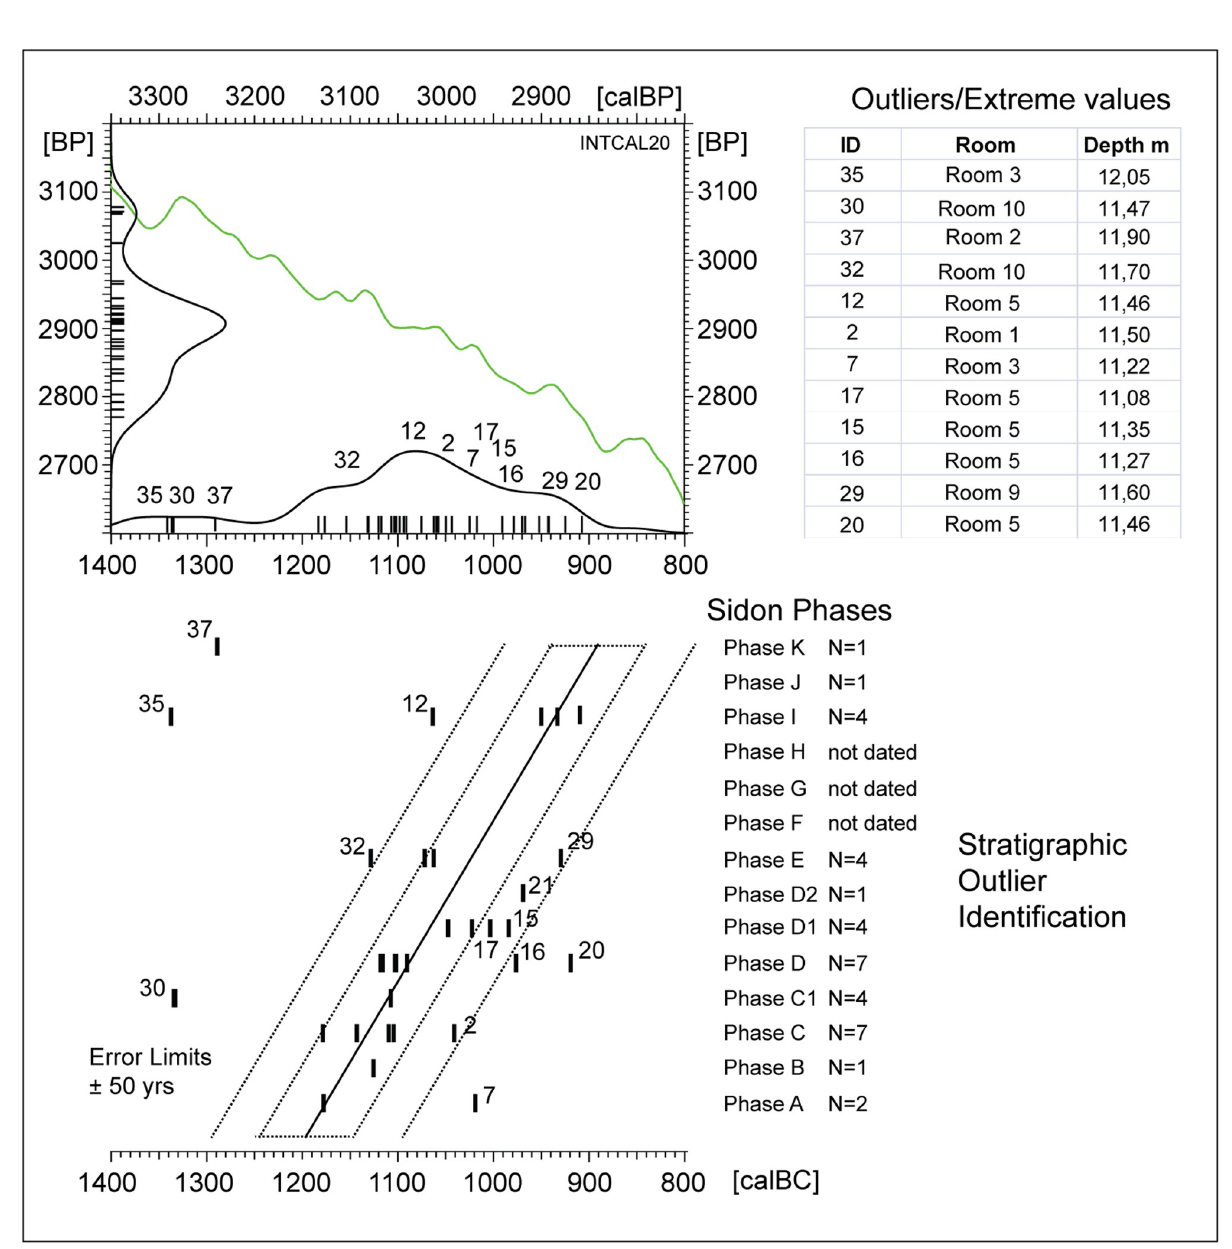
Fig 12. Identification of outliers and extreme 14 C-ages based on barcode representation of Sidon data (Table 1). In this graph all Sidon Phases (A-K) are included, with allowance for not-dated Phases F, G, and H. ( Upper) : 14 C-histogram and calibrated probability distribution of data, numbered according to Table 1, shown in context with IntCal20 (green line). ( Lower) : the same data, but showing barcodes grouped according to Sidon Phase (A-K), with Phases arranged vertically according to their known stratigraphic sequence. Note, empty vertical spaces are assigned to not-dated Phases F, G, and H. This procedure, in combination with the visual setting of oblique error-lines (dashed lines drawn at ± 50yrs (~1 σ ) and ± 100yrs (~2 σ )), facilitates first-order identification of stratigraphic outliers (sample ID: Table 1). Based on this monitoring, 14 C-ages on samples with ID 7, 30, 35, 37 should be treated as outliers. Further outliers (better: extreme 14 C-ages with expected modelling deviations larger than 100 calyrs) are for samples with ID 16, 20, 32, and 12. This remains to be confirmed by explicit modelling. Finally, although to smaller extent, the 14 C-ages on samples with ID 2, 15, 17, 21, and 29 are also forecasted to show modelling deviations, in this case on the level of ~ 50 yrs. Of special interest is the recognition that, for the youngest Phases I, J, and K, apparently only three of the six dates (i.e. 50%) are likely to be in correct stratigraphic order, and all three of these dates are from Phase I. On the older side of the stratigraphy, with ID7 from Phase A clearly too young, there is only one remaining date for each of two earliest Phases A and B. This we judge is an insufficient number for application of advanced statistical studies.